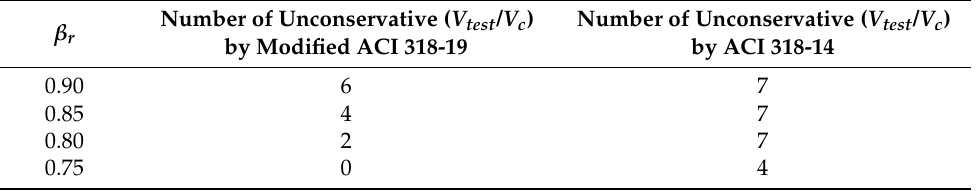
Table 7. Number of unconservative values of shear strength ratio at different proposed β r .